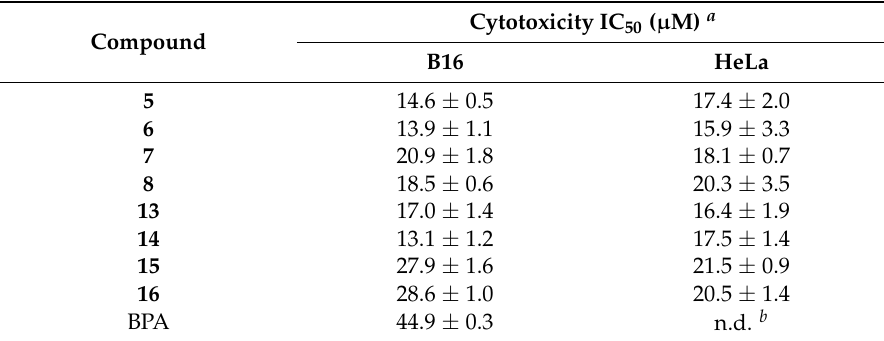
Table 3. Cytotoxicity (IC 50 ) of B16 melanoma and HeLa cervical carcinoma